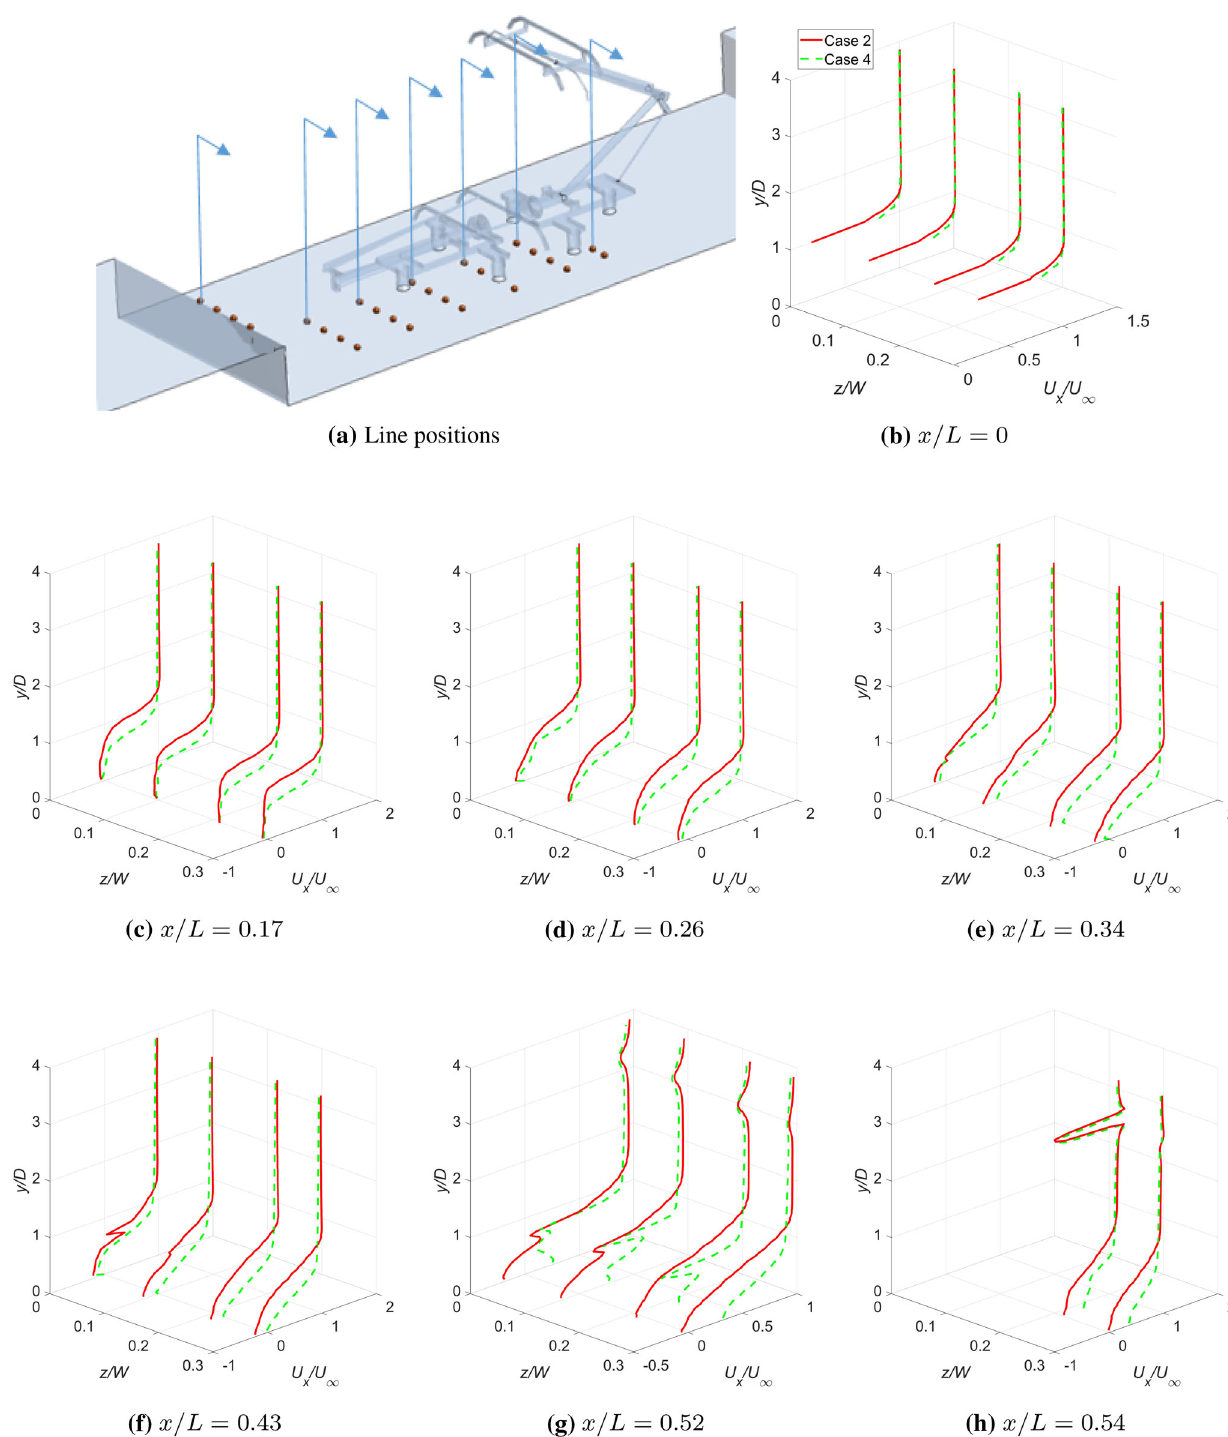
Fig. 13 Time-averaged streamwise velocity U x from case 2 with rectangular cavity and case 4 with rounded